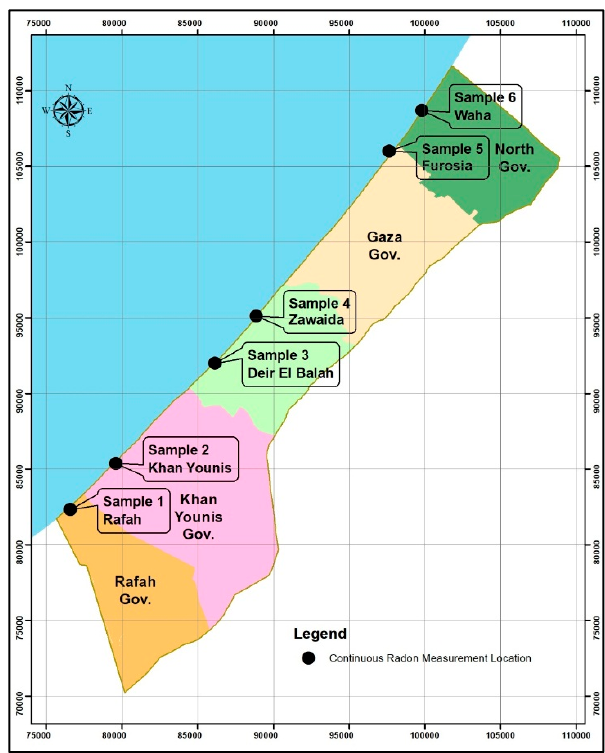
Figure 3. Continuous radon measurement location.